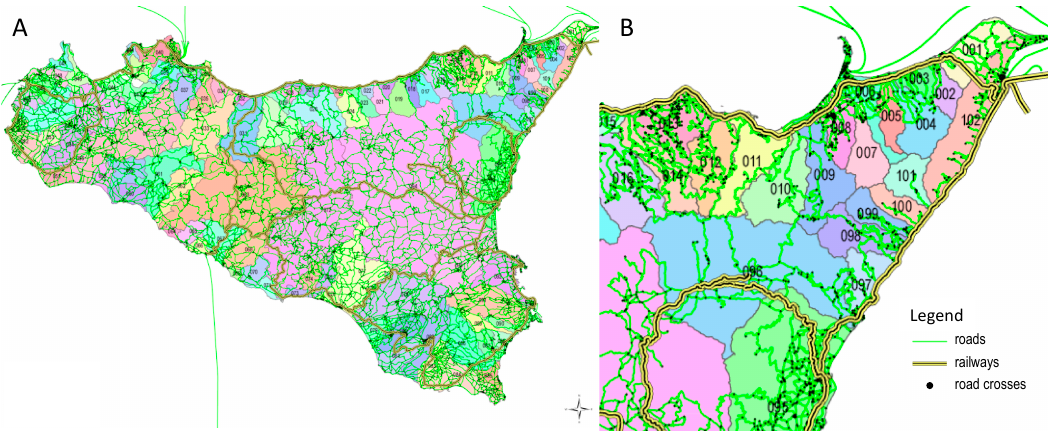
Figure 8. Anthropological arrangement in Sicily ( A ) and in the Fiumedinisi river basin area ( B ). Geosciences 2018 , 8 , x FOR PEER REVIEW